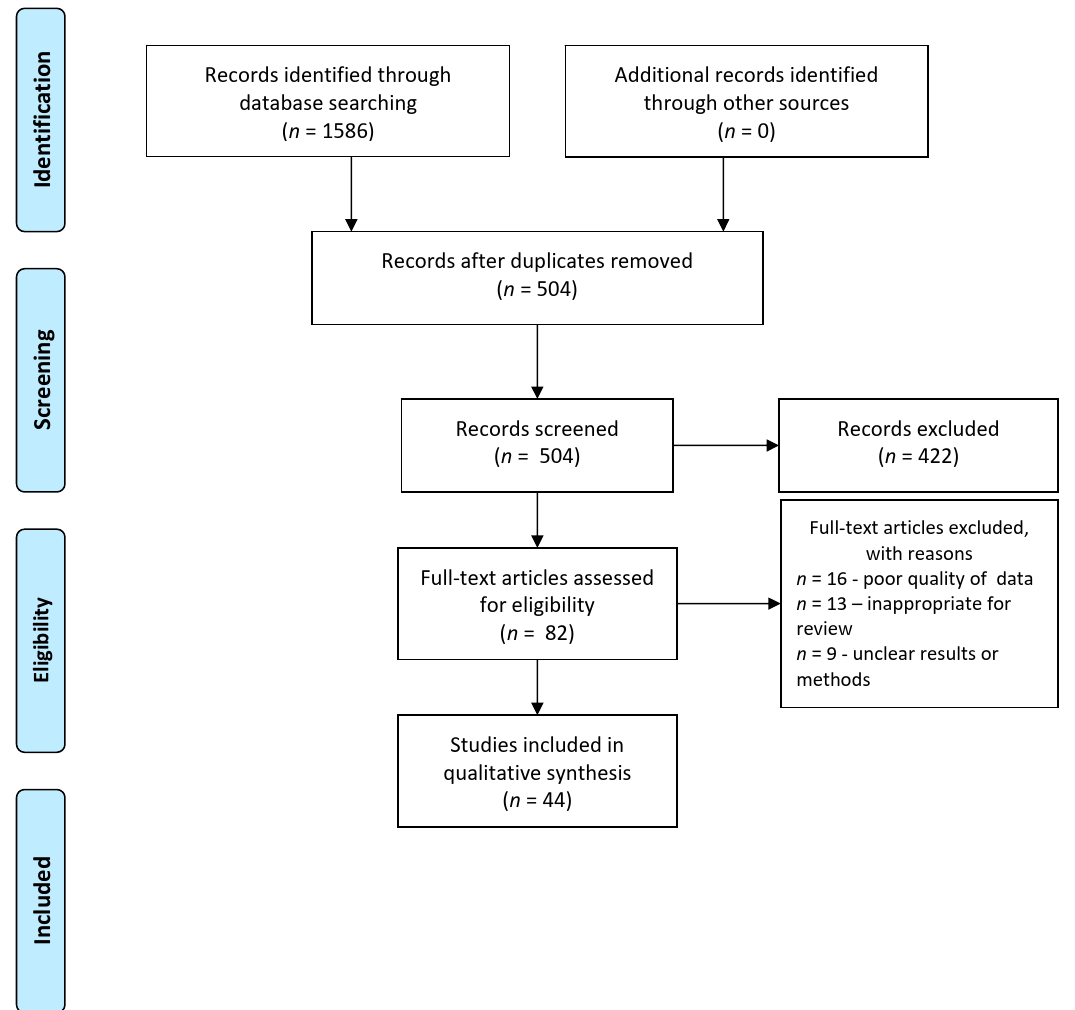
Figure 1. Preferred Reporting Items for Systematic Reviews and Meta-Analyses (PRISMA)